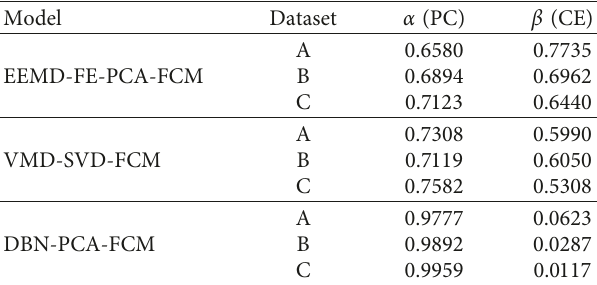
Table 4: The results of α (PC) and β